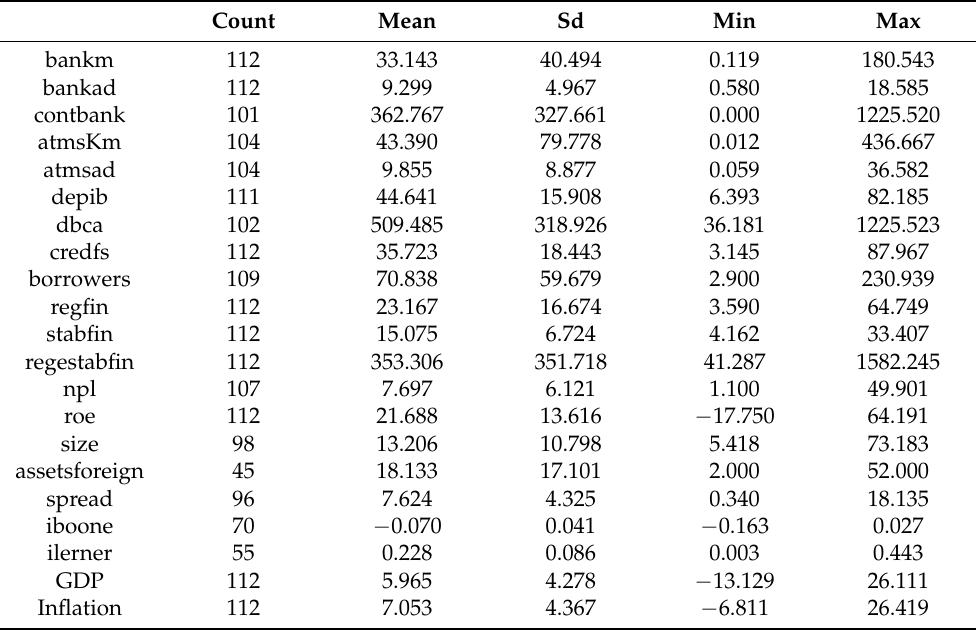
Table 3. Descriptive statistics for SAARC (South Asian Association for Regional Cooperation)